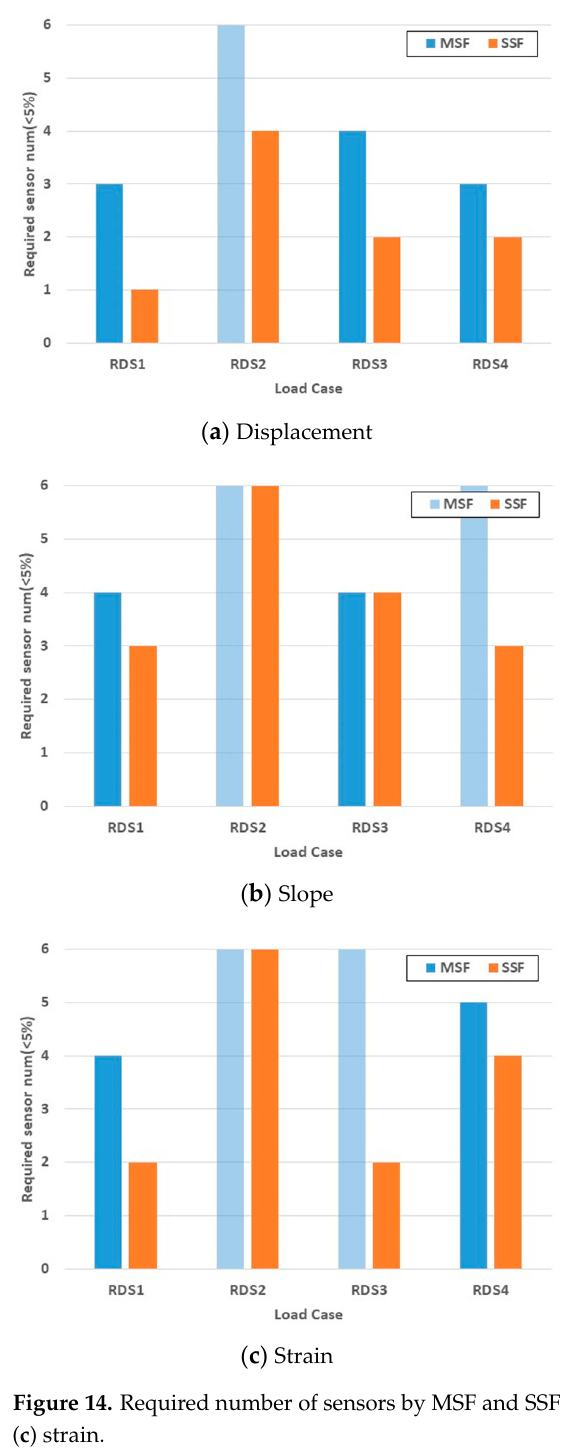
Figure 14. Required number of sensors by MSF and SSF (NMAPE < 5%): ( a ) displacement, ( b ) slope, ( c ) strain. ( c )